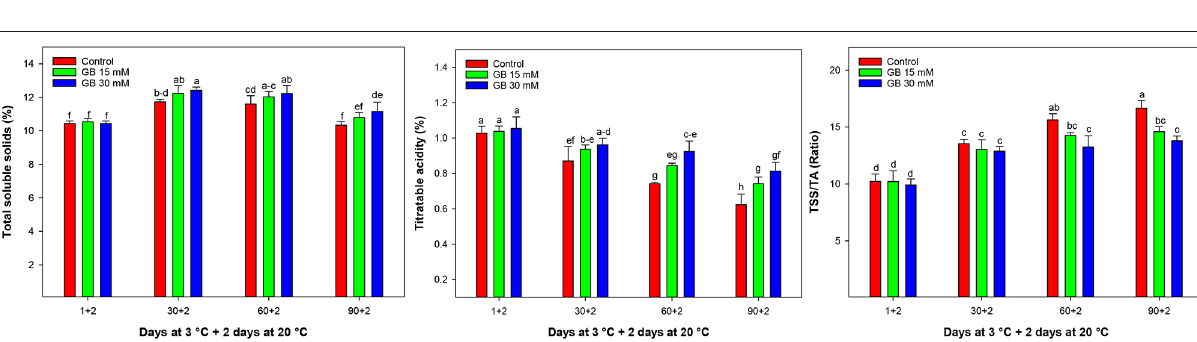
FIGURE 1 | Changes in weight loss and fruit firmness in control and GB-treated fruit of “Moro” blood orange at 3 ◦ C. Different letters and vertical bars show a significant difference ( p < 0.05) and standard errors ( ± SE) of means, respectively.